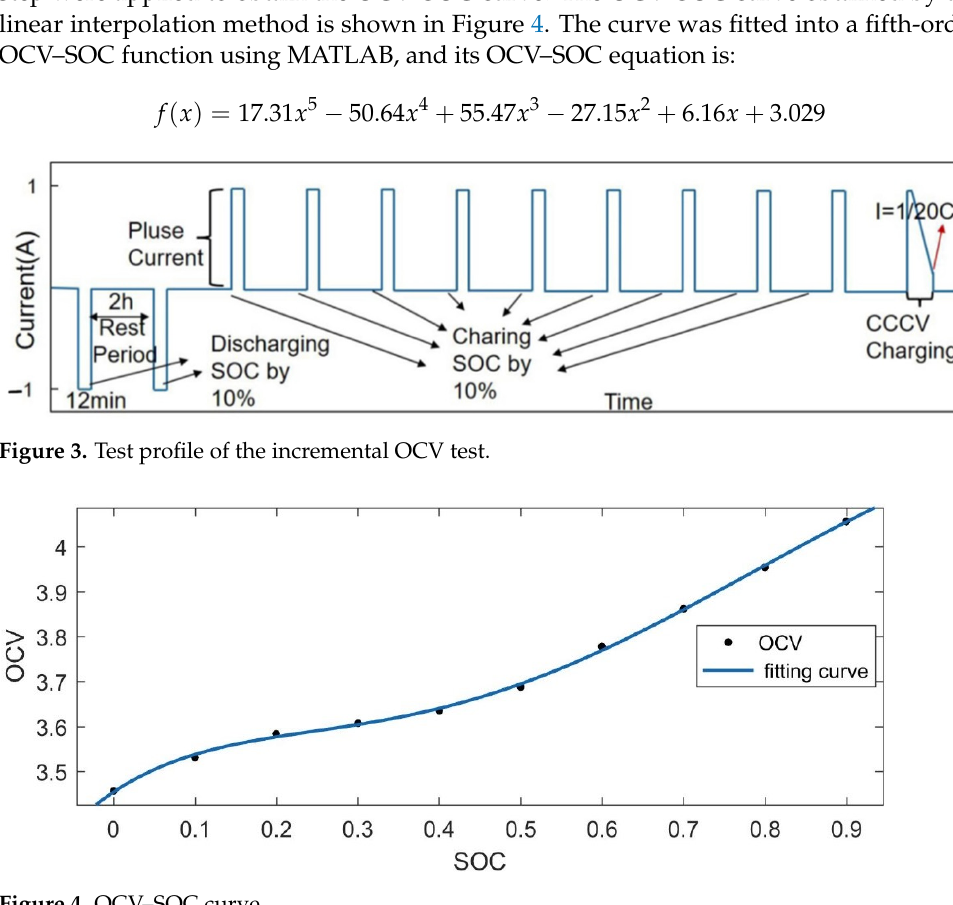
Figure 4. OCV–SOC curve. Figure 4. OCV–SOC